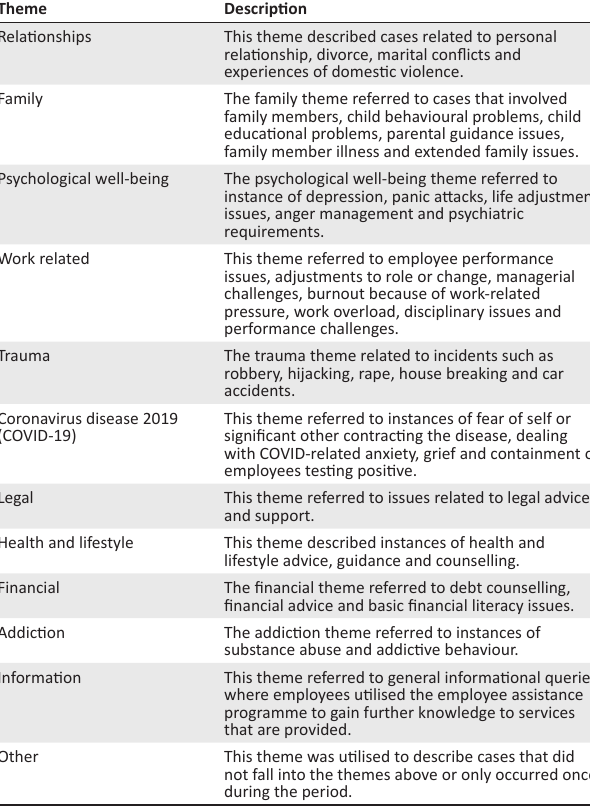
TABLE 3: Overview of themes